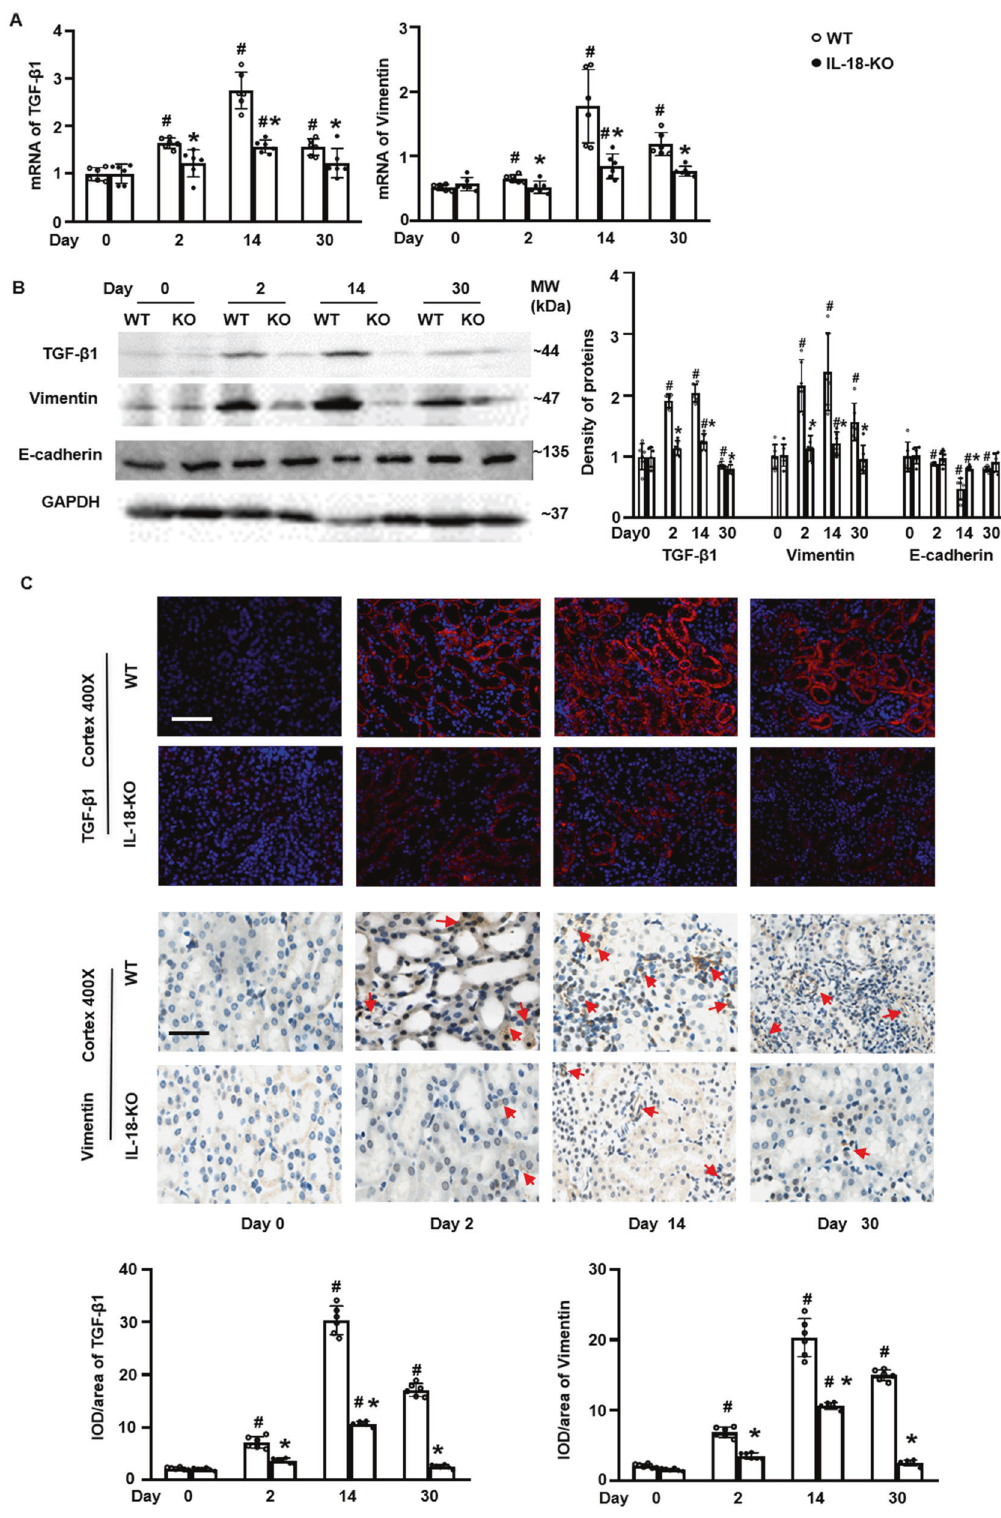
Fig. 3 IL-18 deletion suppressed tubular cell transdifferentiation at day 14 after folic acid injection to mice. A Renal mRNA of TGF- β 1, and Vimentin. B Renal proteins of TGF- β 1, vimentin, and E-cadherin analyzed by Western blotting and the density of blots. C Immuno fl uorescent (IF) staining of TGF- β 1 and immunohistochemistry (IHC) staining of vimentin (red arrows) and semi quantitative analysis in renal cortex. Magni fi cation, 400×, bar = 50 um. Data represent Mean ± SD ( n = 6, # p < 0.05, other groups vs. day 0; * p < 0.05, KO vs. WT).